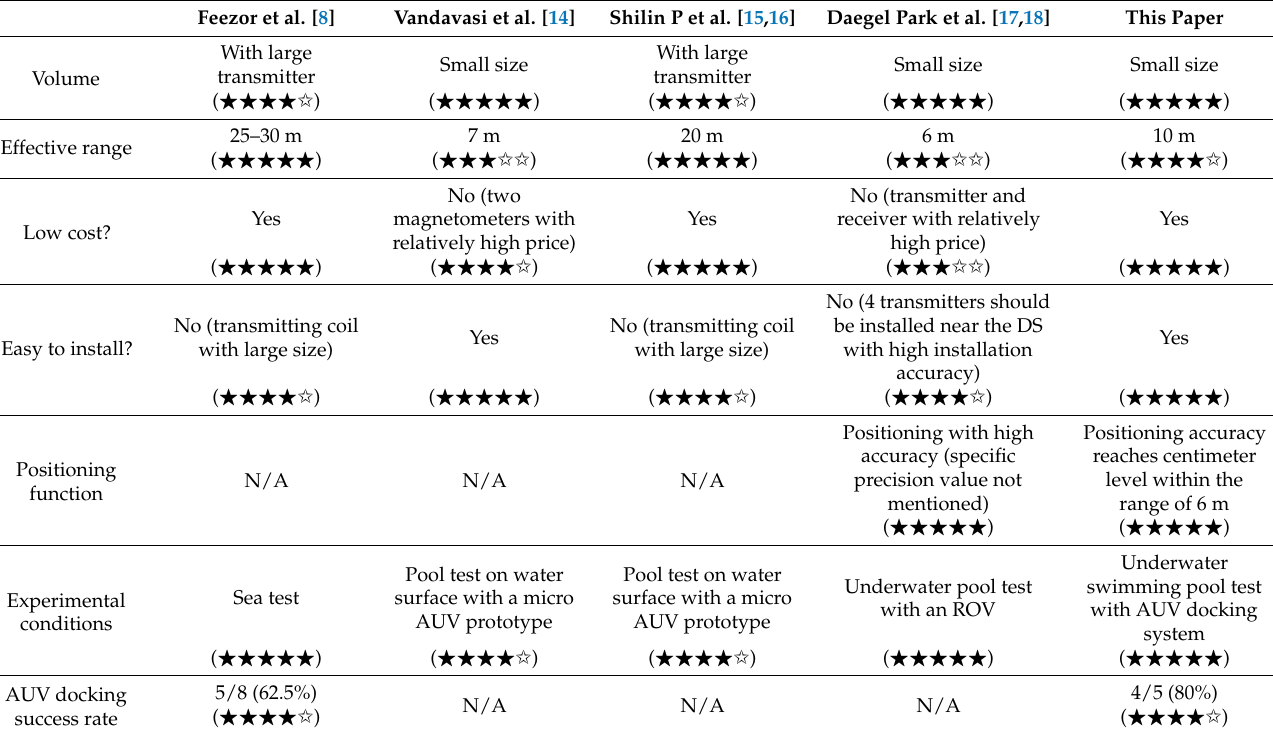
Table 7. Comparison of electromagnetic guidance schemes (five solid stars indicate full marks).